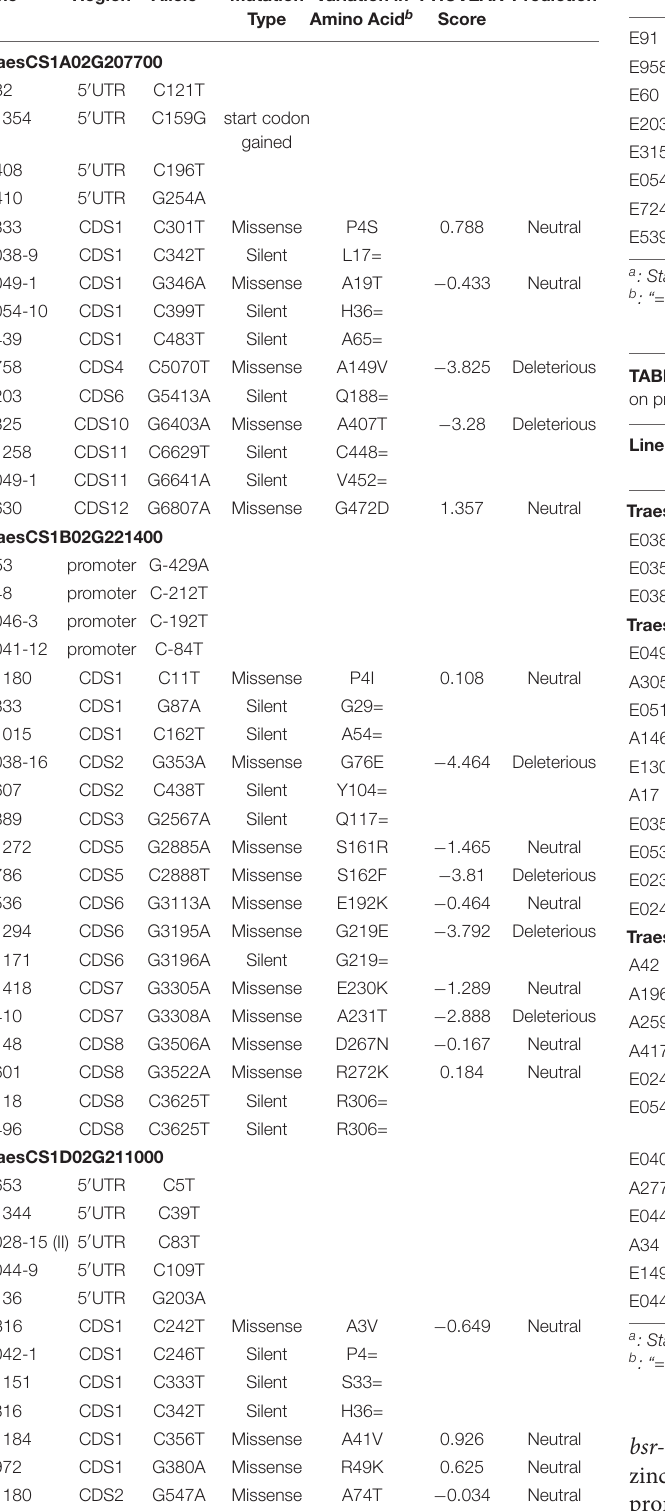
TABLE 2 | SNPs identified in Bsr-k1 wheat orthologs and their predicted impact on protein function. Line Region Allele a Mutation